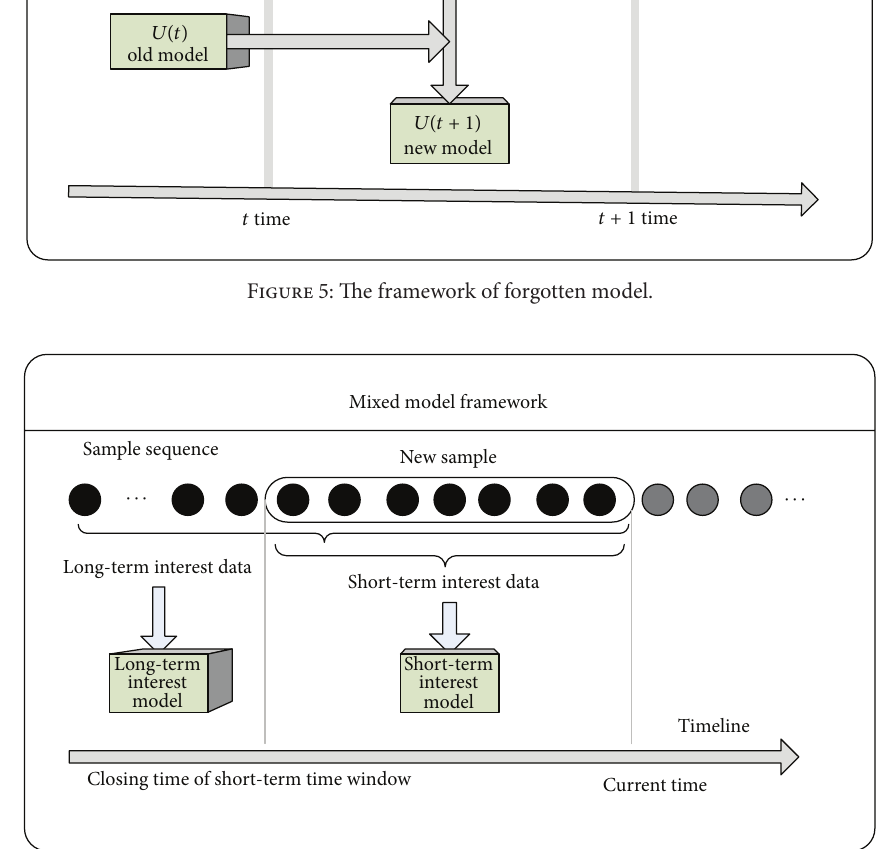
Figure 6: The framework of mixed interest